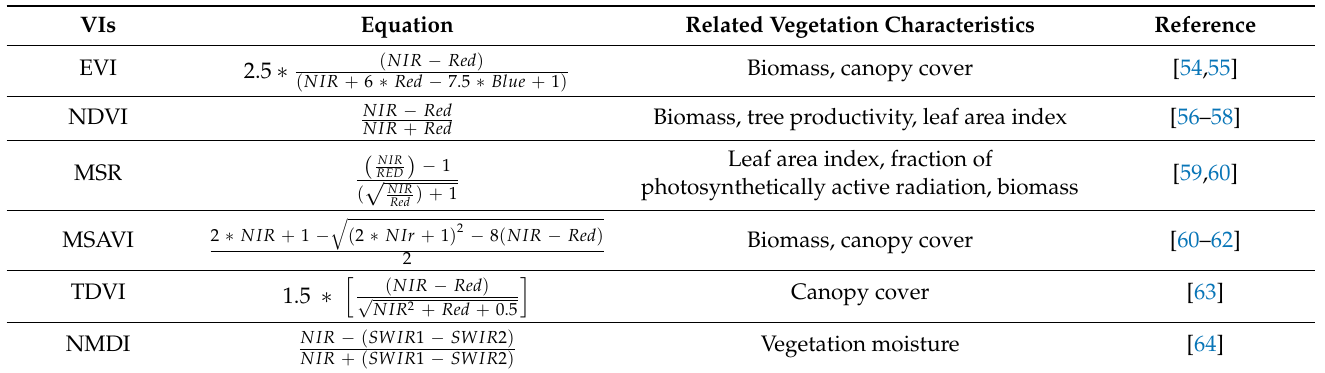
Table 1. VIs considered in the study.